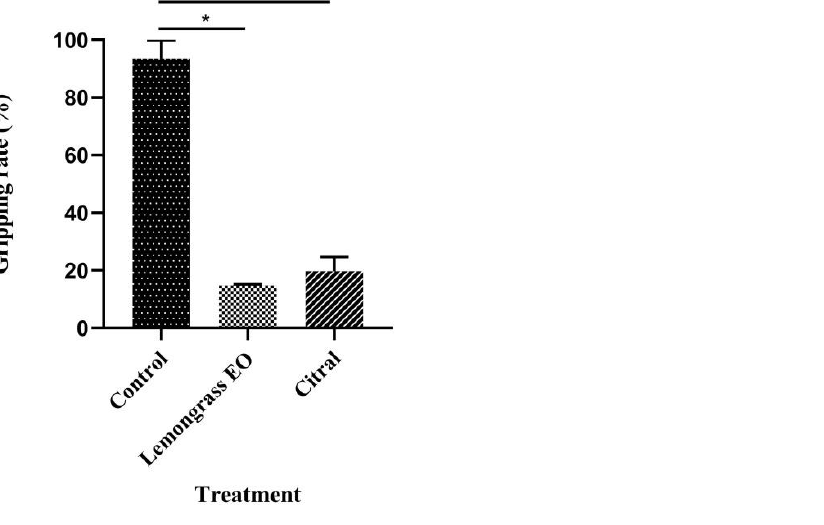
Figure 2. Effect of lemongrass EO and its major constituent on the gripping behavior of R. flaviceps workers. Mean (±SD) values with * show significant differences ( p < 0.01), according to Tukey’s HSD test.